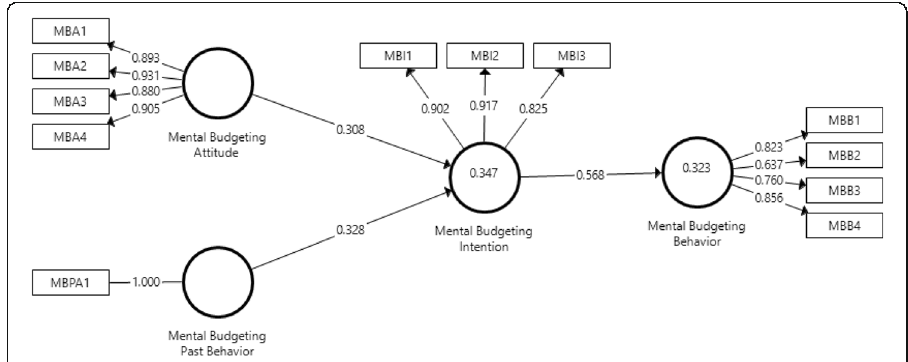
Fig. 2 Results of Measurement